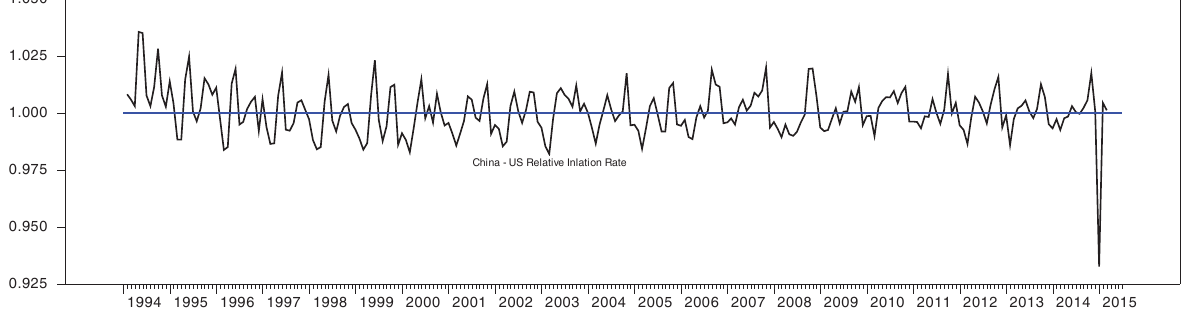
Fig. 1. China’s inflation rate relative to U.S.’s inflation rate